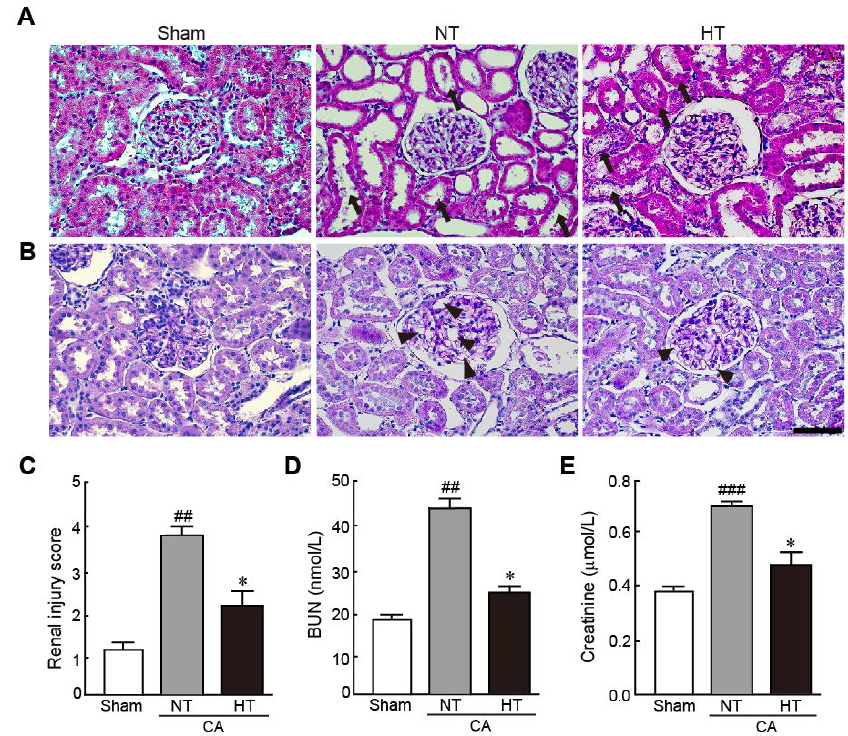
Figure 3. Olanzapine-induced TH attenuates renal injury in CA-induced rats. Representative photographs of H&E ( A ) and PAS staining ( B ) using renal tissues from rats after CA and ROSC with or without olanzapine-induced TH ( n = 5 per group). Arrows and arrowheads indicate brush borders in renal tubules and glomerular capillaries. ( C ) The renal injury scores of rats after CA and ROSC with or without olanzapine-induced TH. Serum BUN ( D ) and creatine ( E ) levels were measured in rat tissues after CA and ROSC with or without olanzapine-induced TH ( n = 5 per group). Significance is represented as ## p < 0.01 or ### p < 0.001 vs. the sham group; * p < 0.05 vs. the CA + NT group.